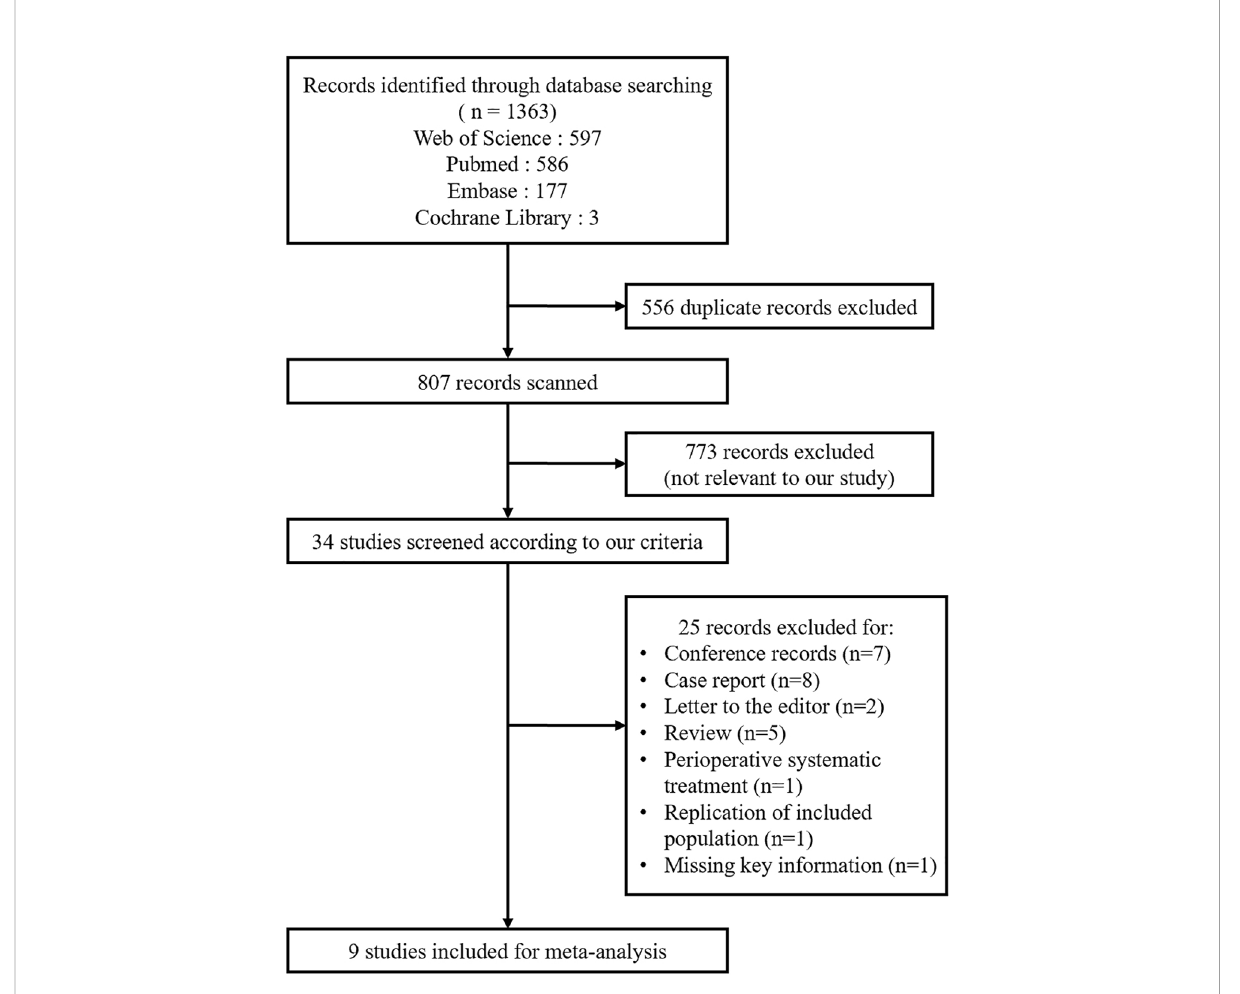
FIGURE 1 The fl owchart for selecting